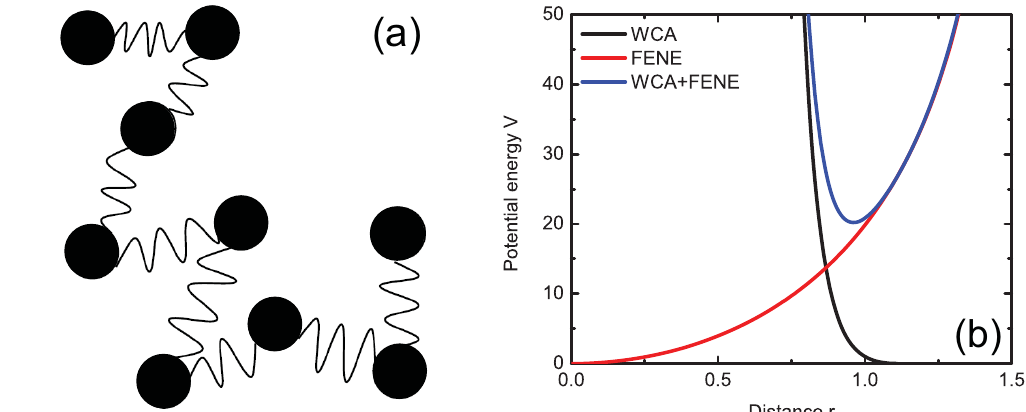
Figure 3. Depiction of ( a ) the FENE model and ( b ) its potential